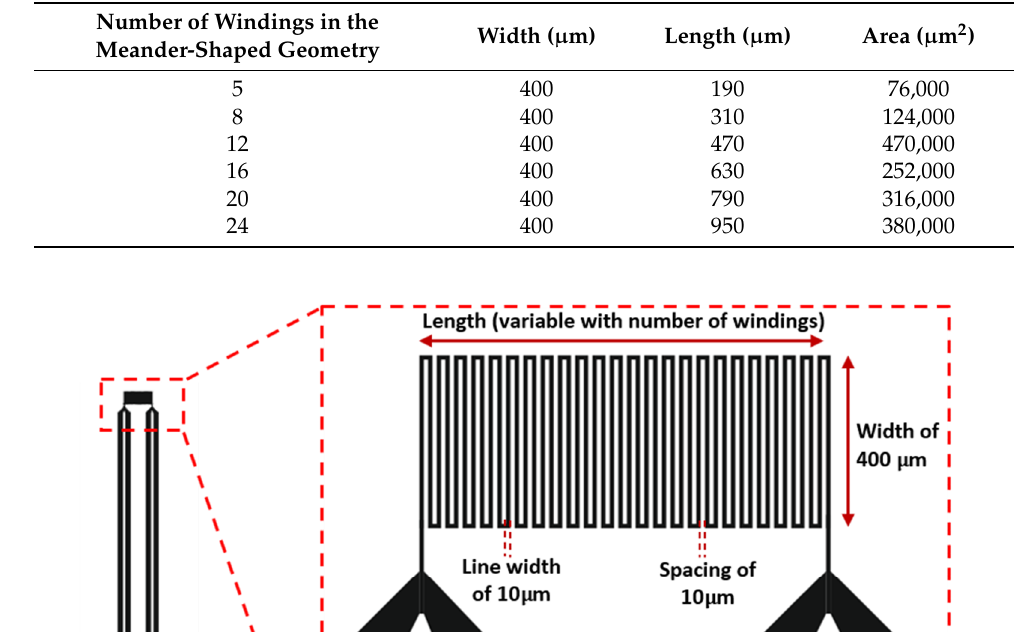
Table 1. Geometrical dimensions of each fabricated sensor.